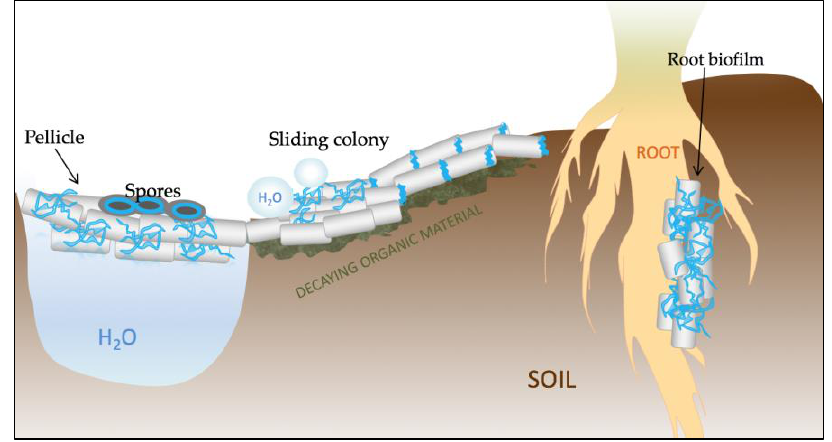
Figure 2. Schematic representation of the various functions of TasA in Bacillus subtilis . TasA (represented in blue) is a key structural element of pellicle biofilms that form at the water – air interface. The protein is also important for proper spore architecture, probably by connecting the cortex with the inner